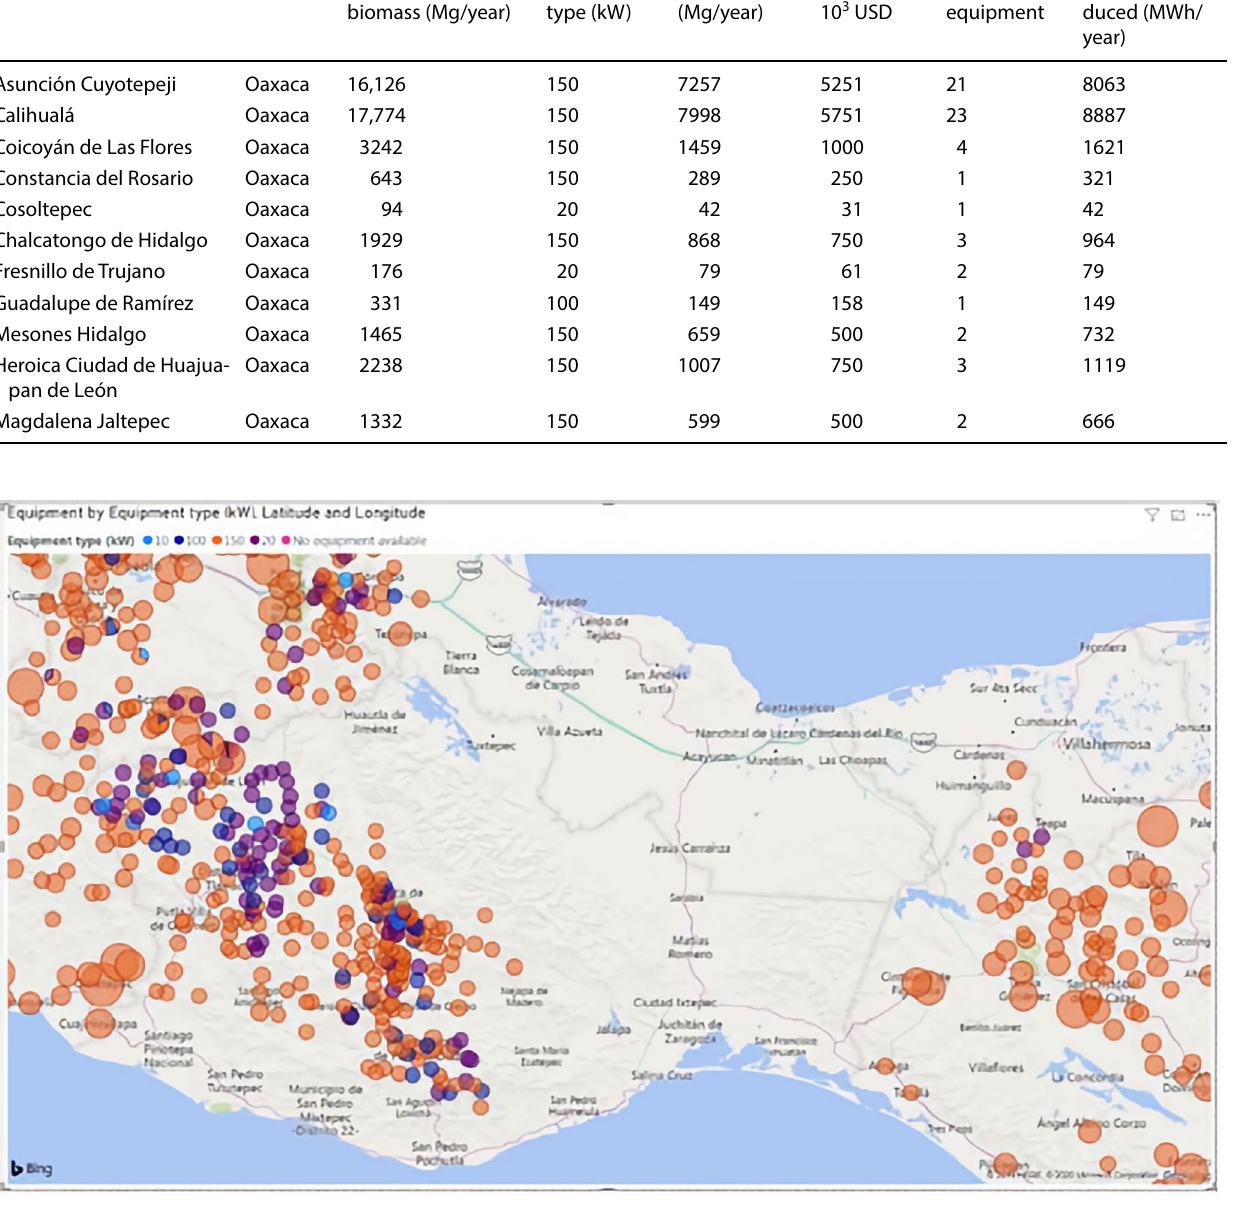
Fig. 11 Equipment with Power type for biomass availability less than 30,000 Mg/year (Close up view for various